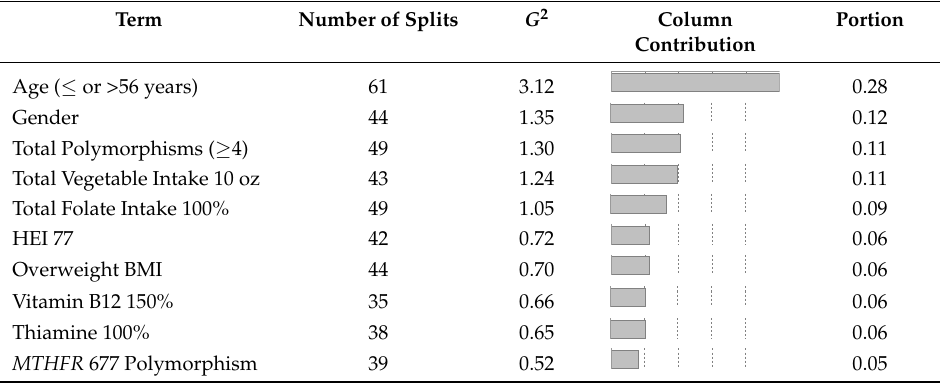
Table 4. Major dietary parameters as predictors of colorectal cancer.